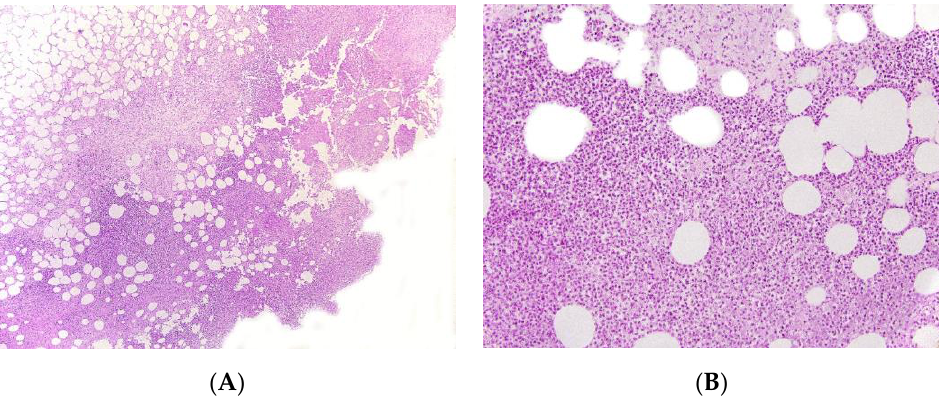
Figure 4. Panniculitis associated with inherited immunodeficiency. ( A ) Lobular panniculitis with dense neutrophilic infiltrate replacing part of the subcutis (original magnification × 80). ( B ) Closer view of showing entrapped adipocytes within the neutrophilic infiltrate (original magnification ×